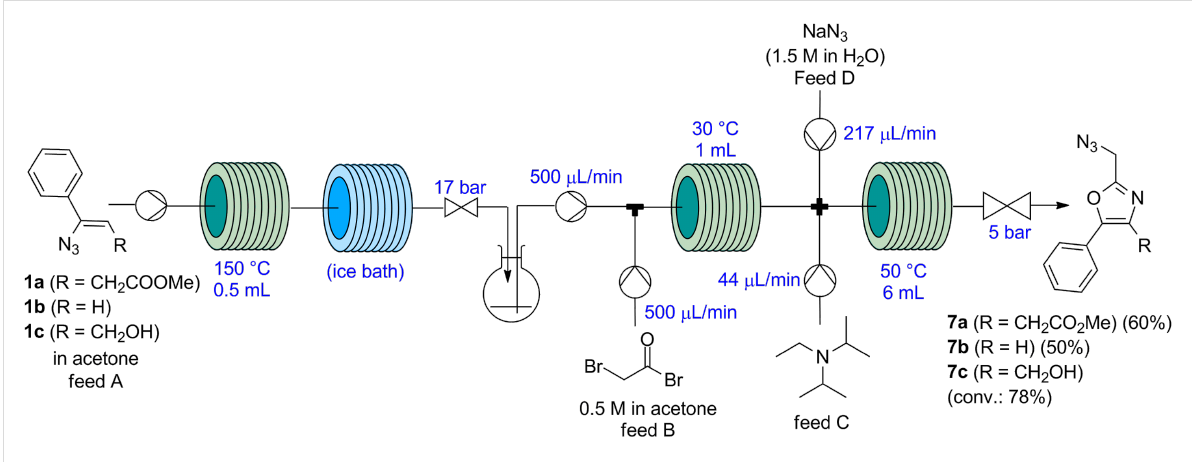
Figure 4: Continuous-flow three-step sequential synthesis of 2-(azidomethyl)oxazoles 7a – c from vinyl azides 1a – c . Yields refer to isolated yields.